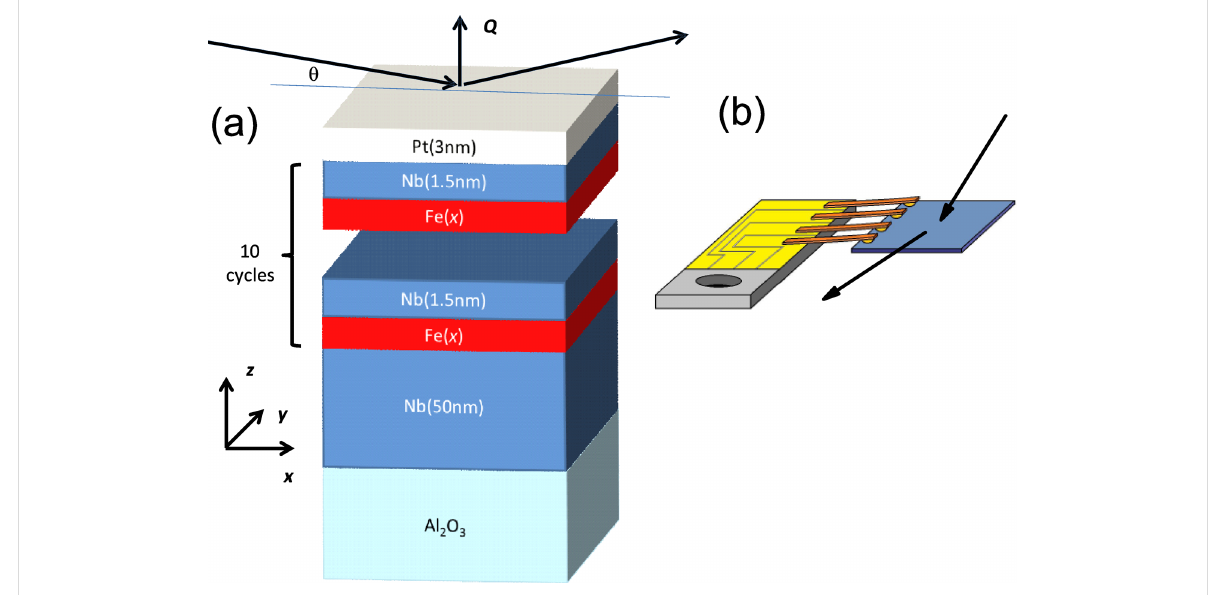
Figure 1: (a) Sketch of the experiment for structure and reflectometric measurements and (b) setup for the transport measurements. Black arrows show the direction of the neutron beam.